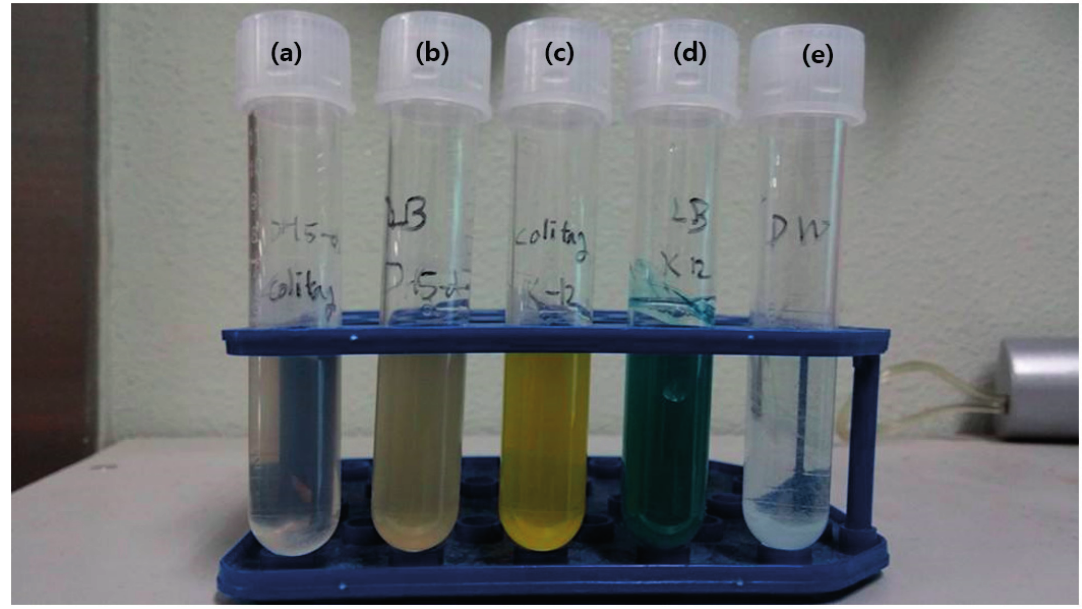
Figure 2. Chromogenic enzyme substrate assay. ( a ) E. coli DH-5 α with Colitag ® ; ( b ) E. coli DH-5 α with LB broth + X-gal; ( c ) E. coli K-12 with Colitag ® ; ( d ) E. coli K12 with LB broth + X-gal; ( e ) Negative